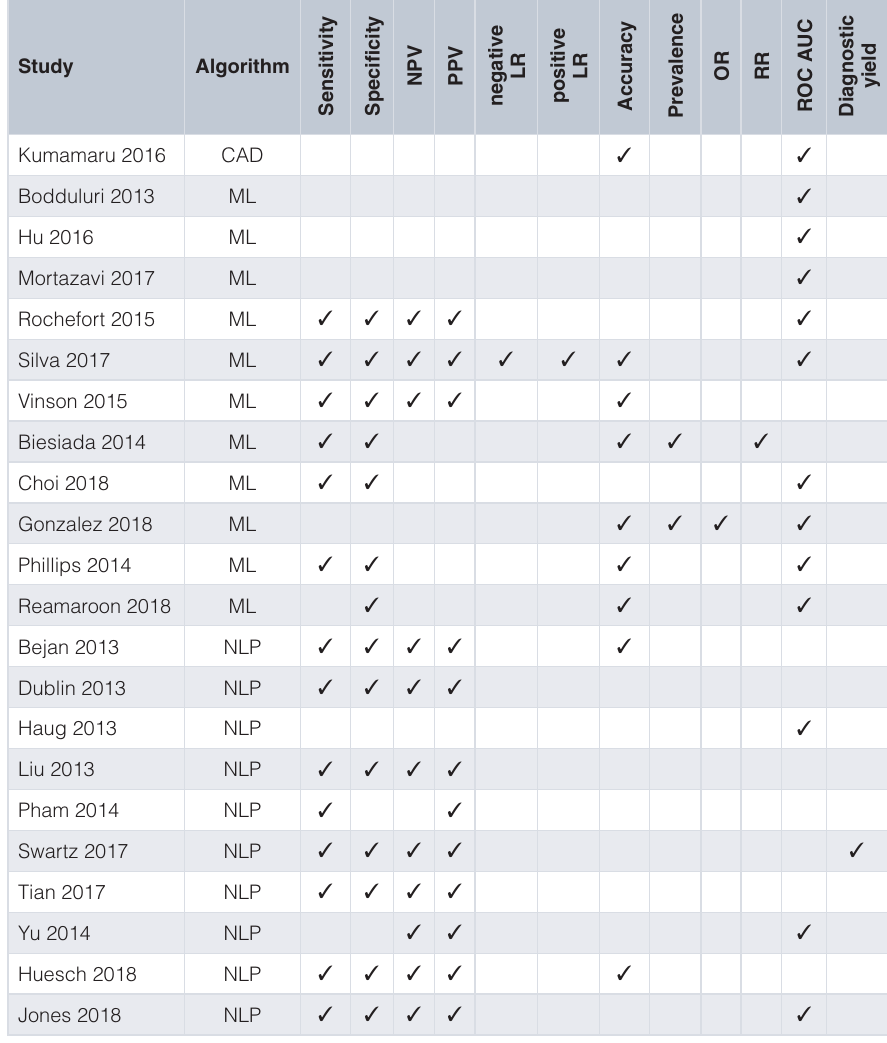
Table 8. Overview of measured outcomes in studies predicting respiratory distress or